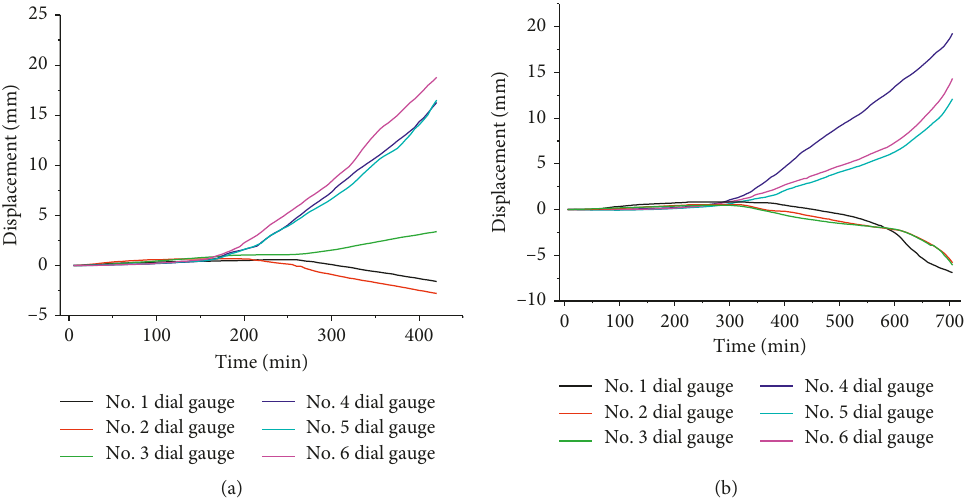
Figure 6: Results of the model test. (a) Pure soil. (b) Soil with